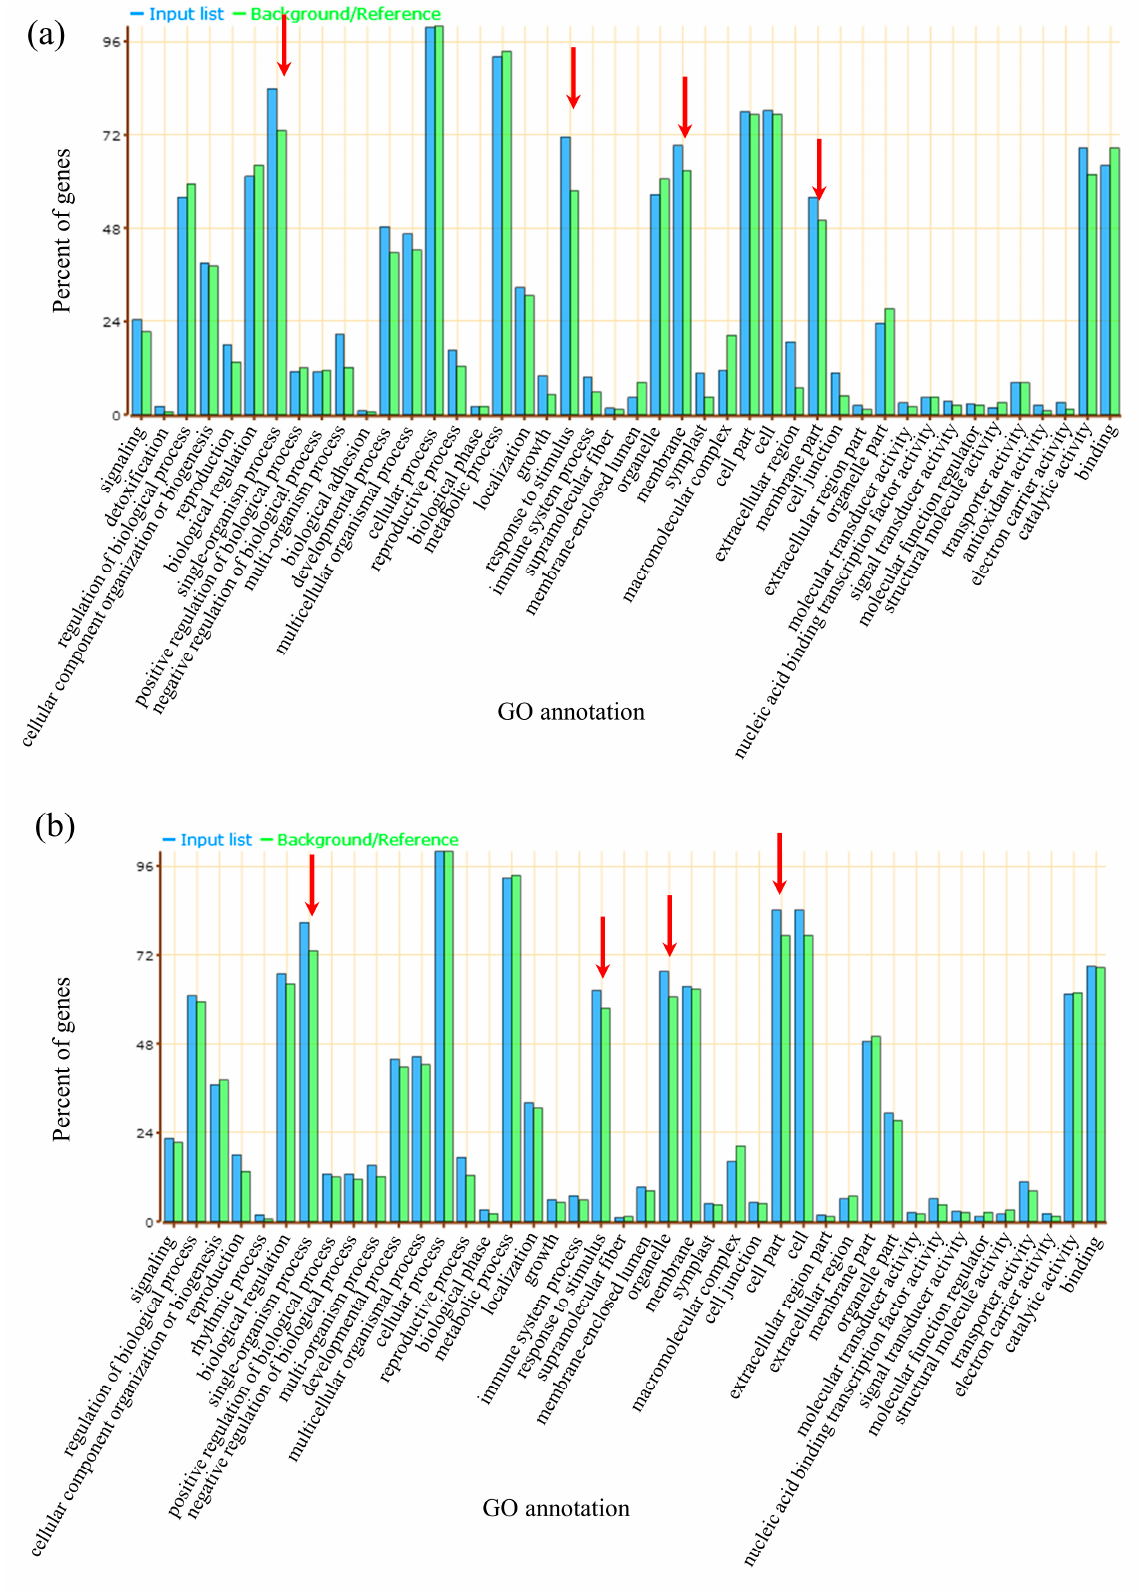
Figure 7. GO enrichment analysis of L282’s specifically expressed DEGs with upregulated ( a ) and downregulated ( b ) expressions at low temperature.